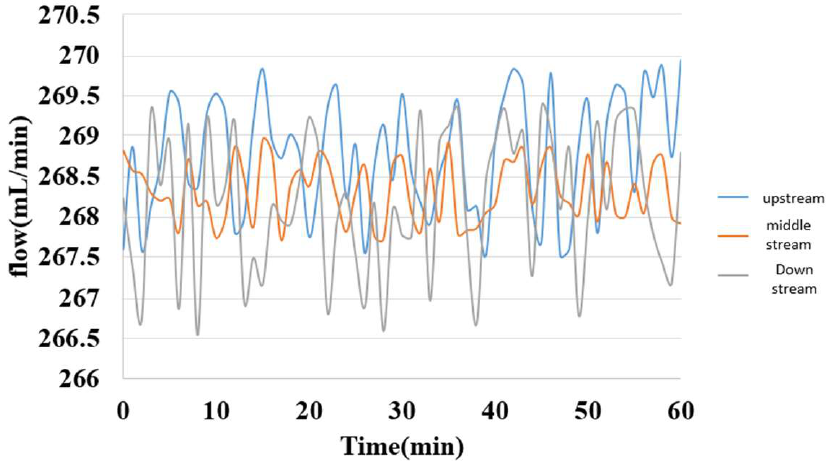
Figure 20. Internal flow distribution of the hydrogen/vanadium redox battery.